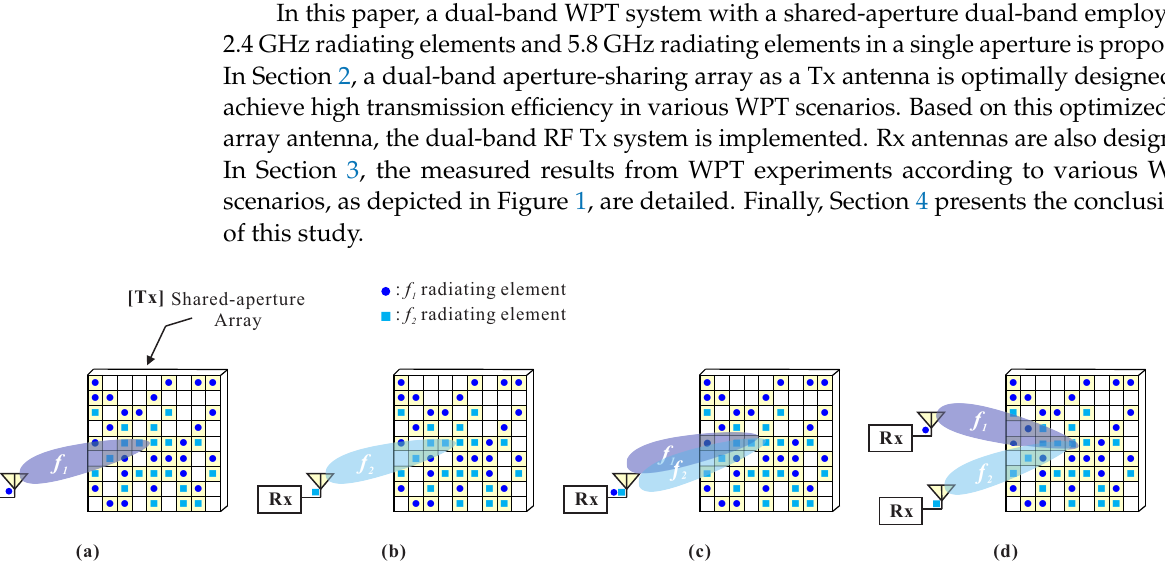
Figure 1. Wireless power transfer (WPT) scenarios according to use of the frequency and the transmission of the beam: ( a ) transmitting f 1 wireless power to an Rx for f 1 , ( b ) transmitting f 2 wireless power to an Rx for f 2 , ( c ) transmitting dual-band wireless power of f 1 and f 2 to an Rx for the dual band, and ( d ) transmitting f 1 wireless power and f 2 wireless power to an Rx for f 1 and to another Rx for f 2 ,